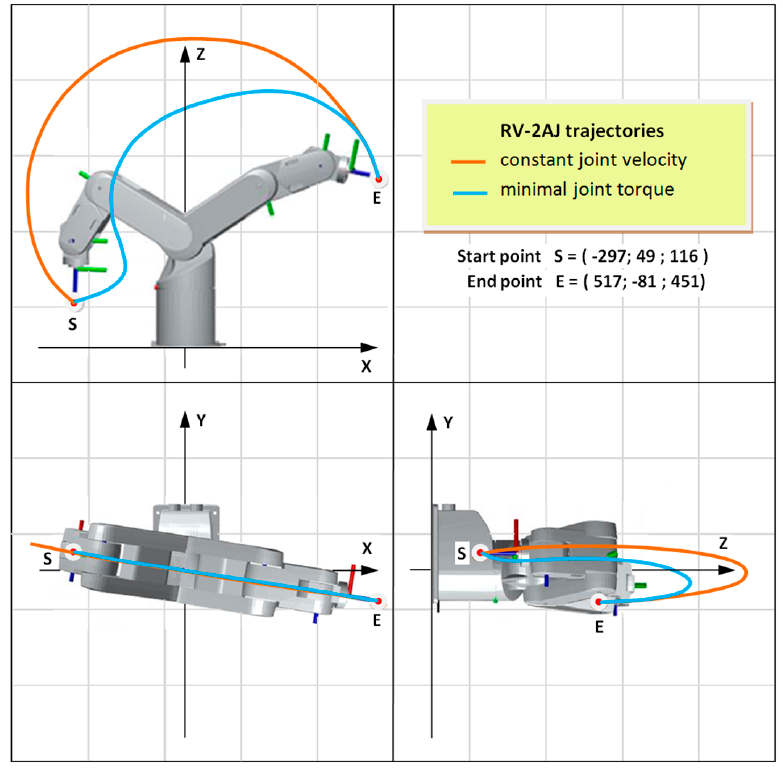
Figure 9. Trajectories between the S start point and E end point.